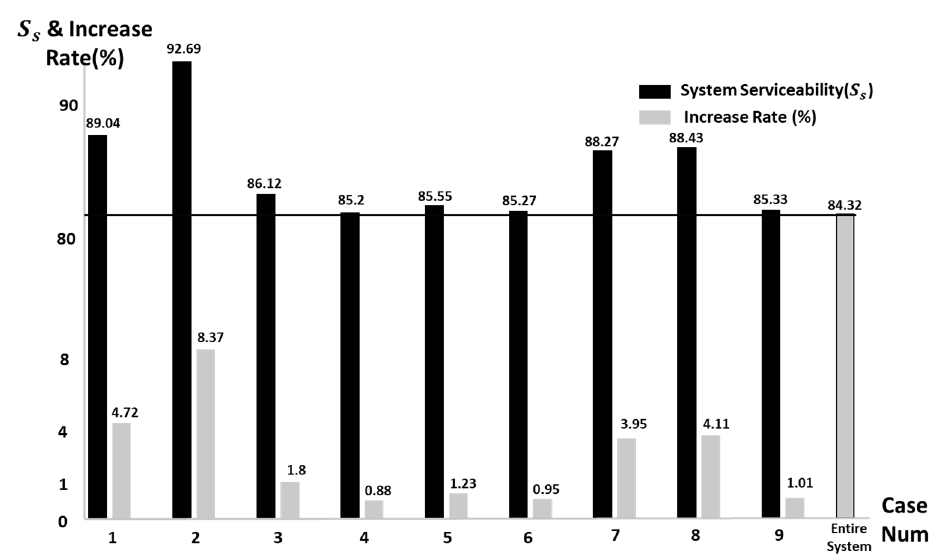
Figure 6. System Serviceability Results by Path.